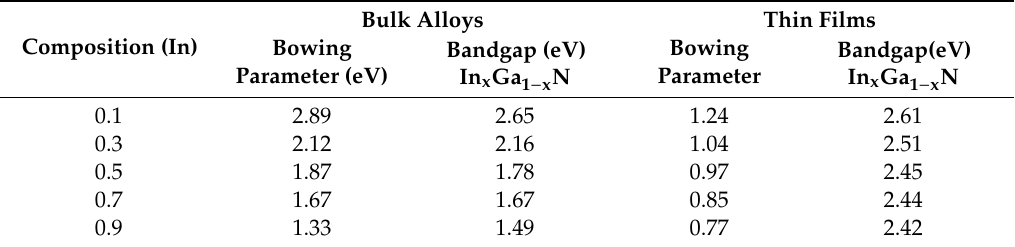
Figure 7. PL-spectra of In x Ga 1 − x N thin films deposited at (0.1 ≤ x ≤ 0.9). Table 4. Optical properties of In x Ga 1 − x N as bulk alloys and thin